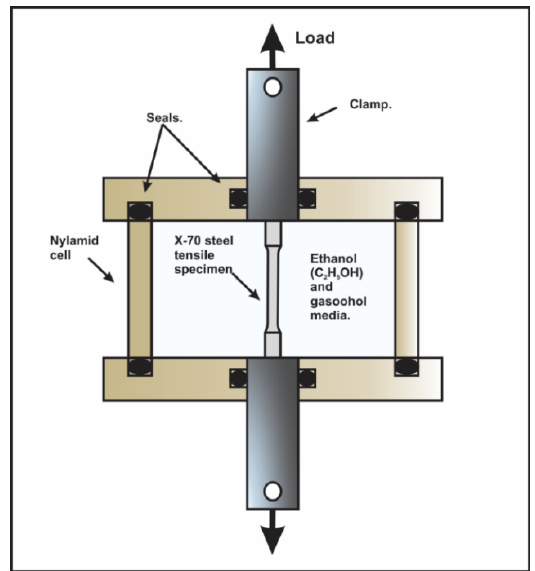
Figure 4. Schematic of the Nylamid